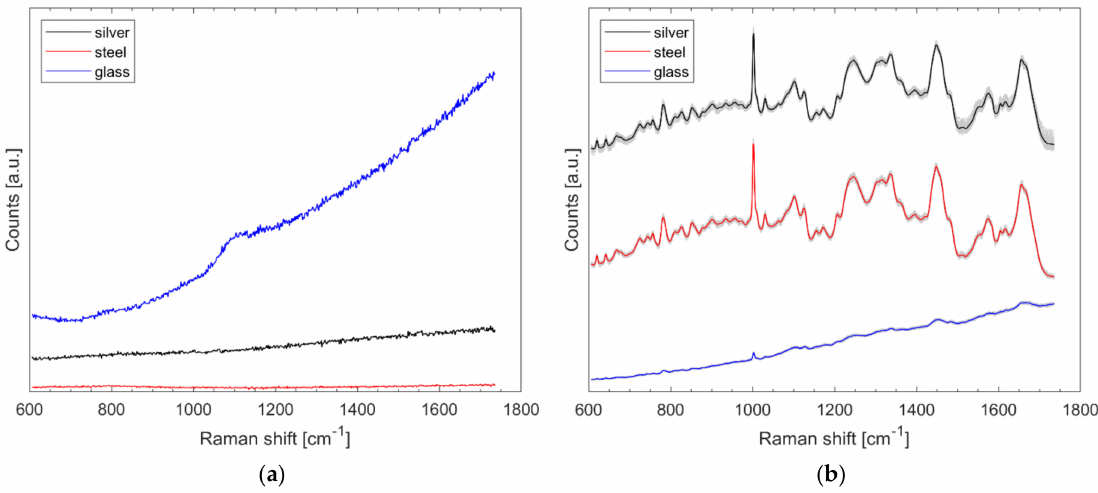
Figure 1. Untreated Raman spectra collected from protected silver mirror slide, stainless-steel slide, and glass slide ( a ) and 85 normalized Raman spectra of B. diminuta on each named substrate with arbitrary offset for better visualization ( b